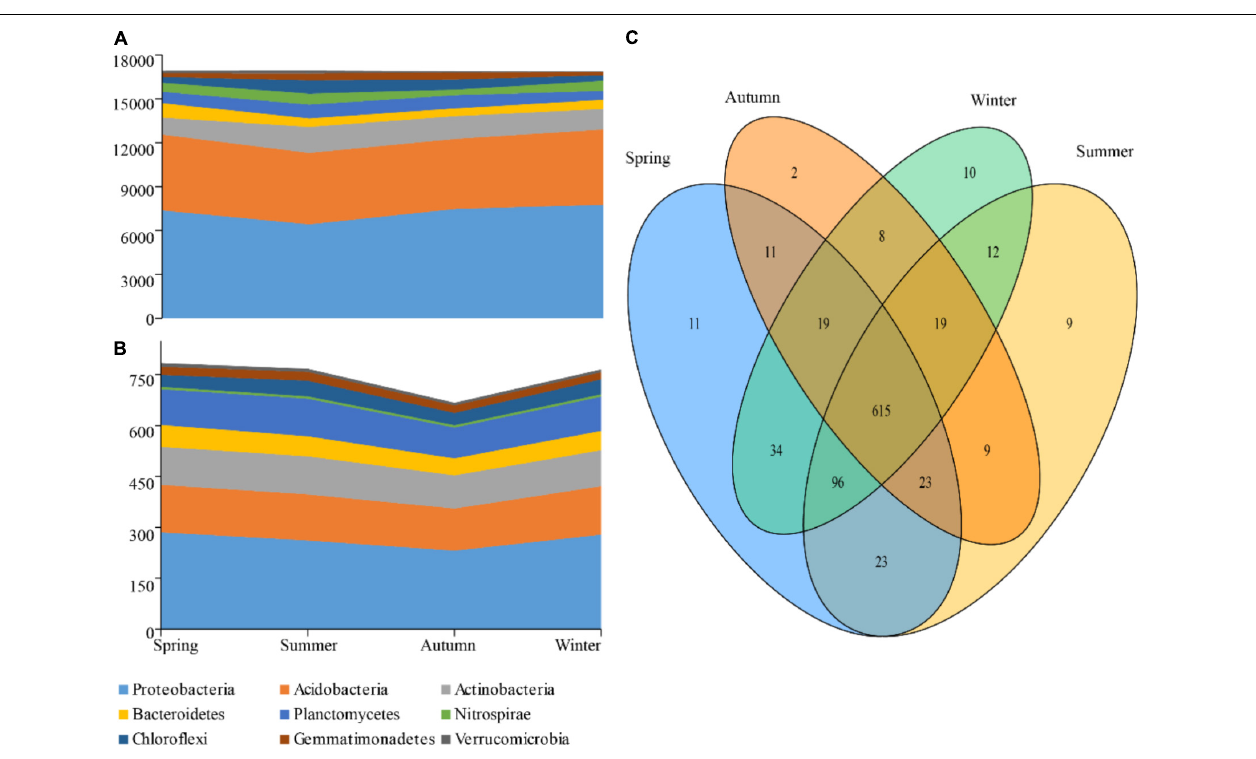
FIGURE 2 | Taxa dynamics and Venn diagram of soil bacterial communities. The reads number (A) and OTUs (B) that are present and shared in at least 0.5% of the population at indicated seasons are aggregated and colored by phylum on a stream-graph; (C) Venn digram showing the different OTU numbers between each two